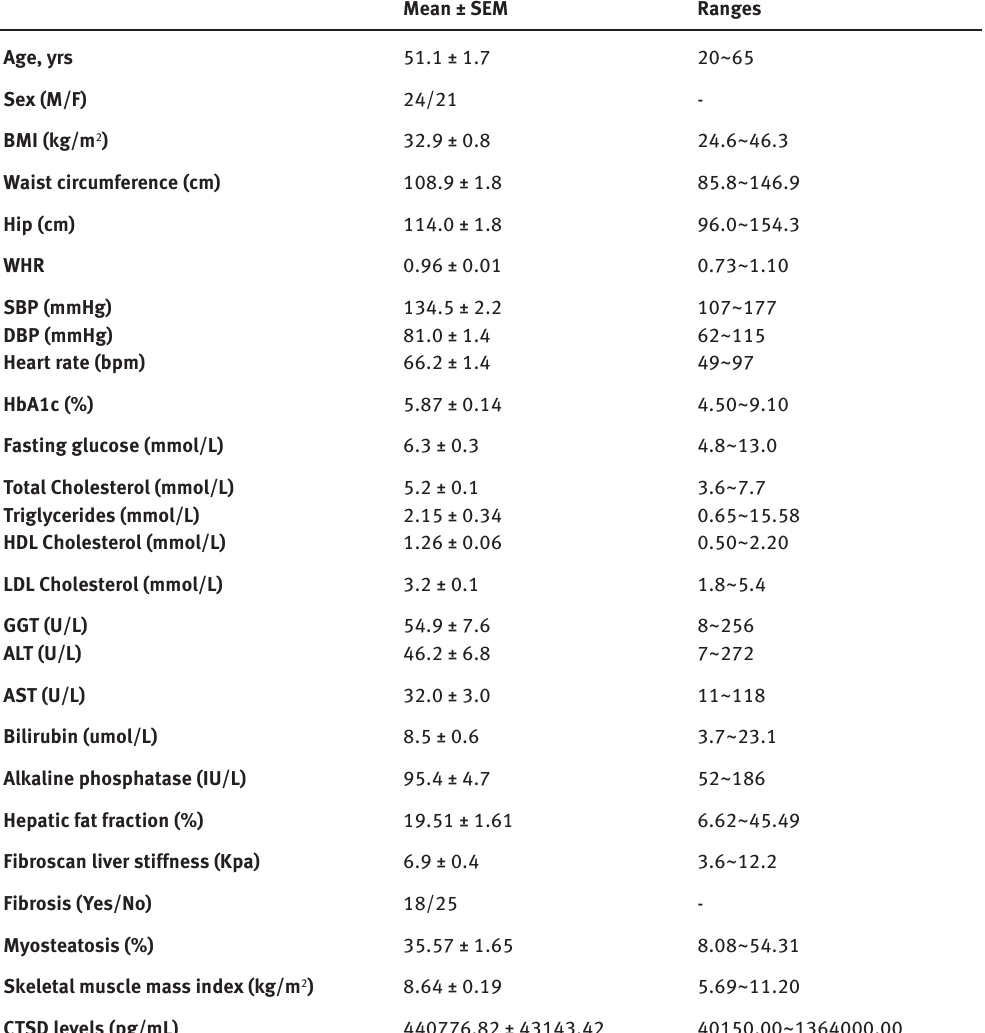
Table 1: Baseline clinical characteristics of the study